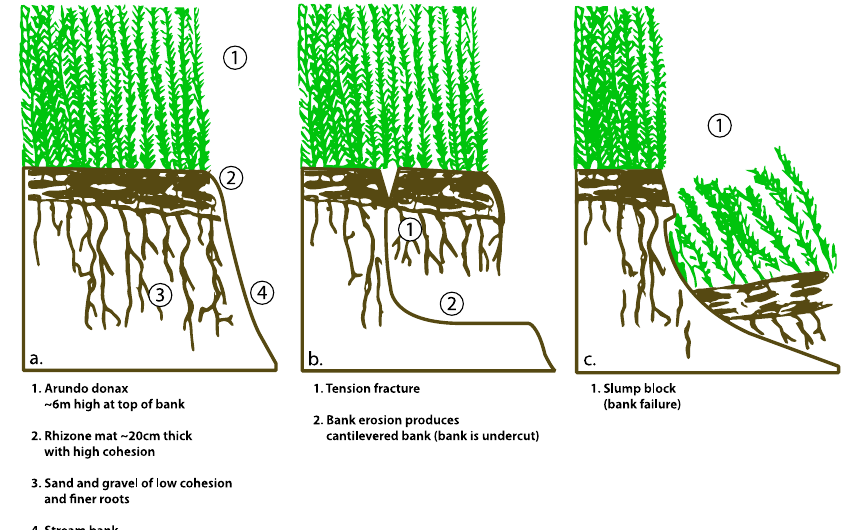
Figure 16. Idealized diagram of how bank failures may develop with channel banks and floodplain dominated by A. donax .